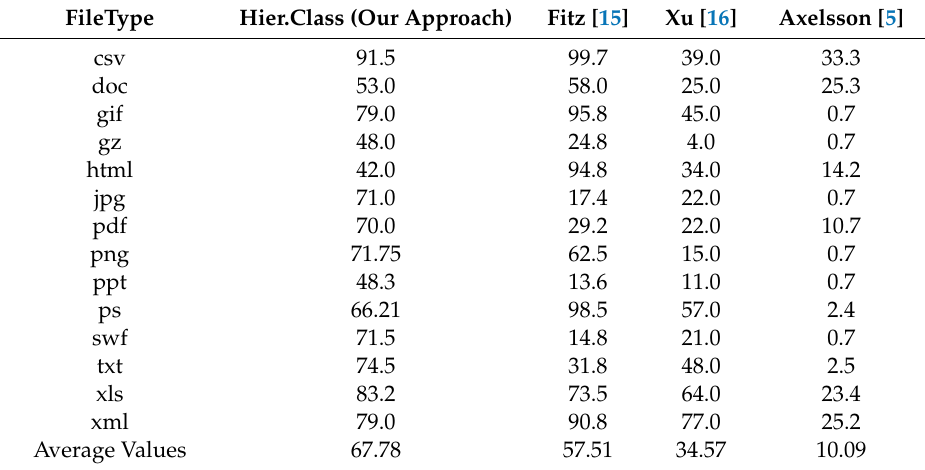
Table 7. Average accuracies of some previous works for the 14 file types in our study